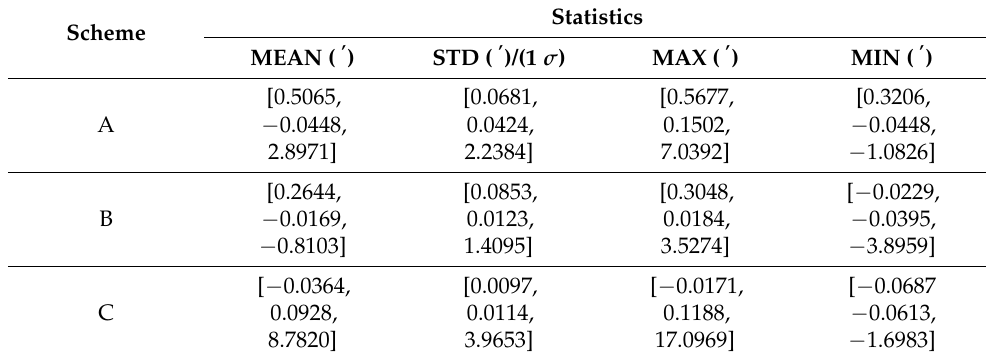
Table 5. Statistics for simulation result.